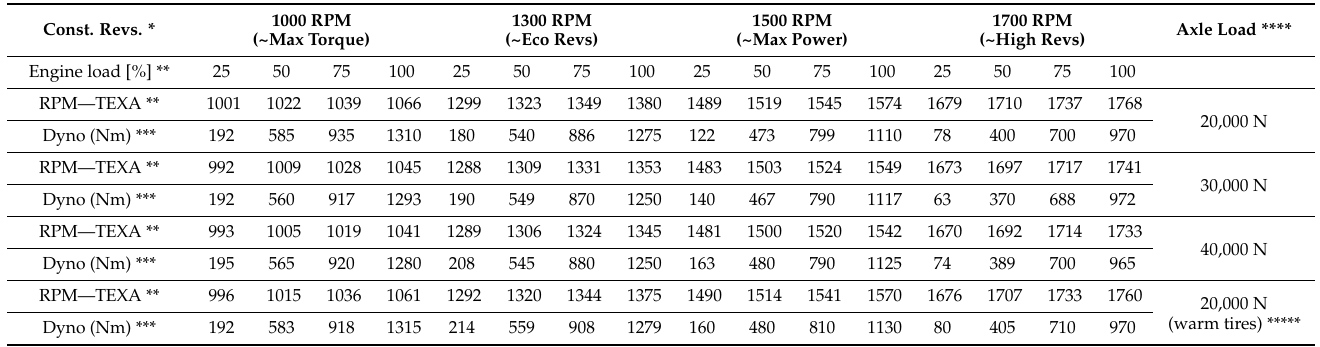
Table 6. Table of the results of tests of slip of tires on rollers.